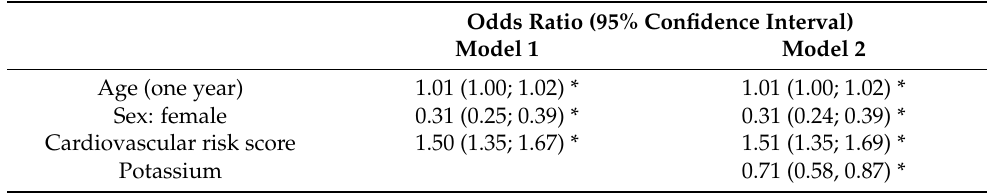
Table 5. The odds ratio for a score based on the number of classical risk factors (hypertension, diabetes, chronic kidney disease, and smoking) of coronary atherosclerotic lesions with ≥ 30% stenosis, adjusted for age, sex (Model 1), and, additionally, potassium (Model 2).